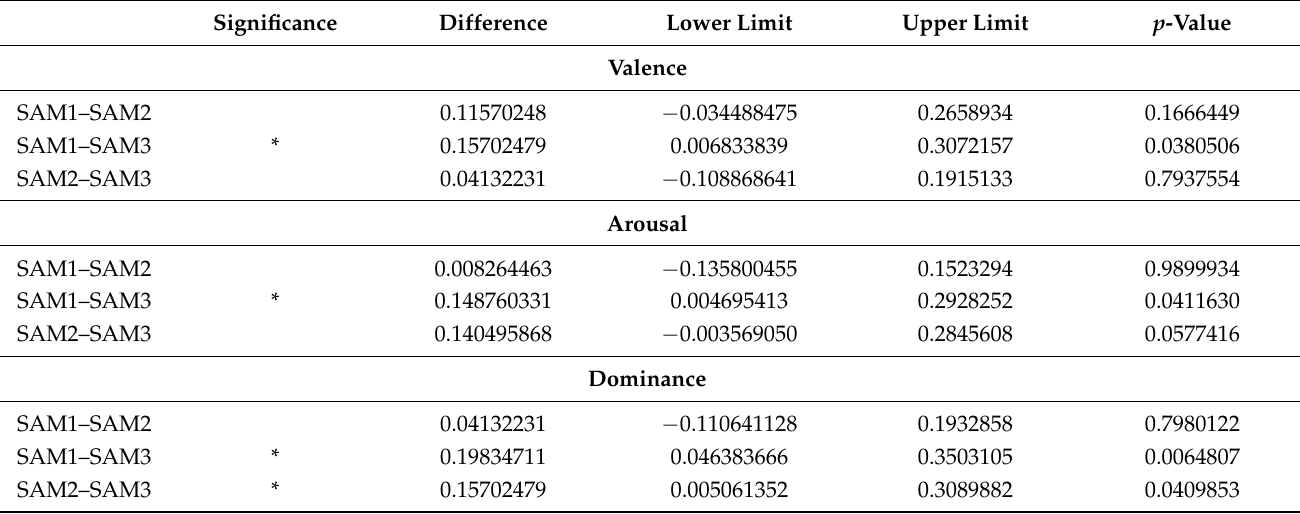
Table 6. Results from the SAM tests showing the significant differences between test stages.